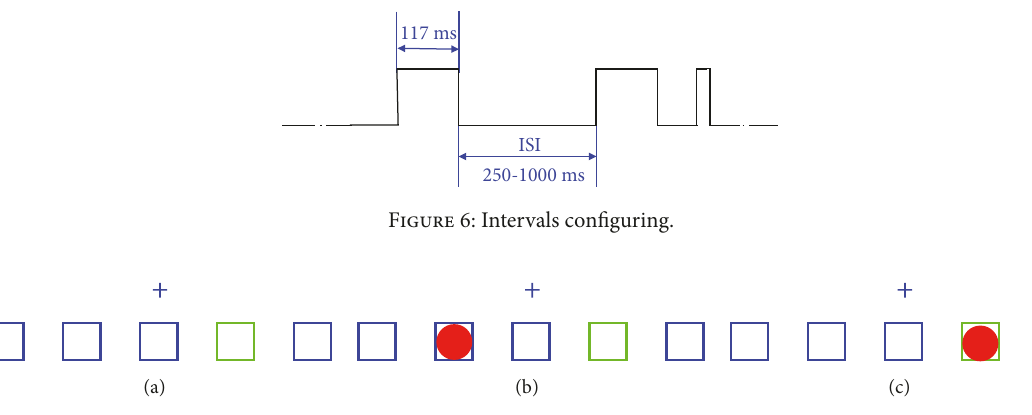
Figure 7: Test 5 boxes. (a) Initial setup. (b) Stimulus unattended. (c) Attended stimulus (event).